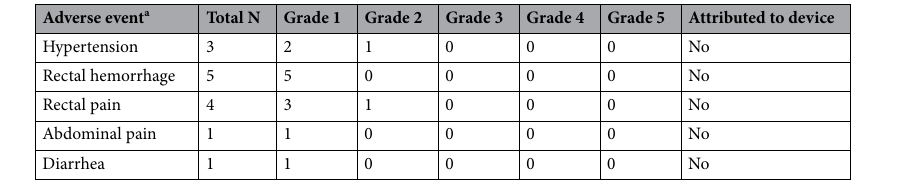
Table 2. Adverse events and attributions. a CTCAE Version 5.0, published: November 27, 2017,